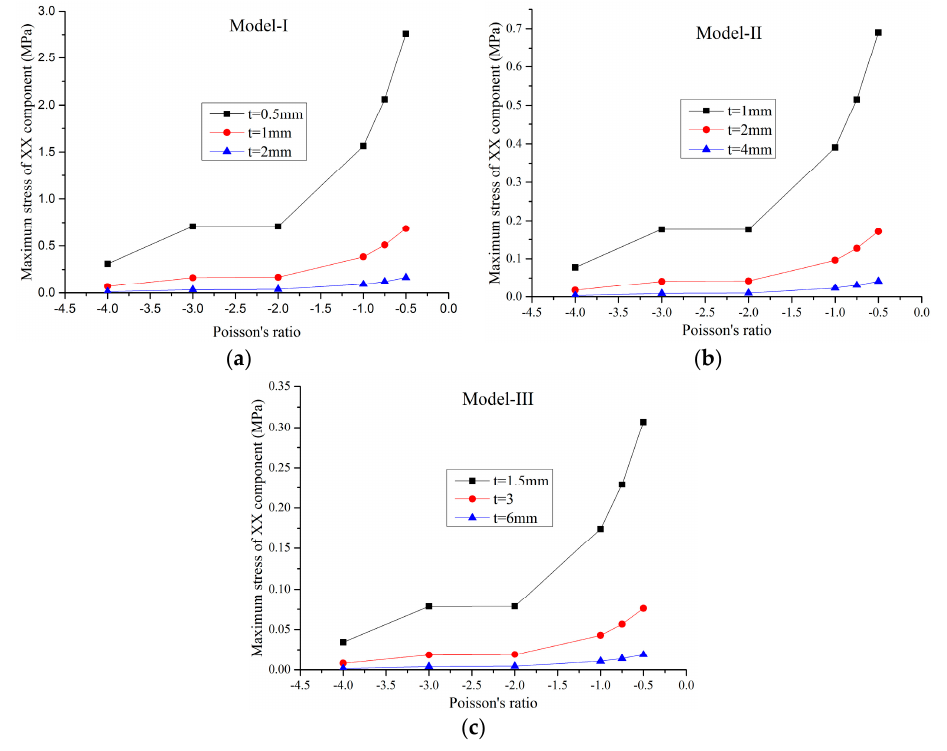
Figure 3. Maximum stress of the XX component versus the Poisson’s ratio: ( a ) Model-I; ( b ) Model-II; ( c ) Model-III.